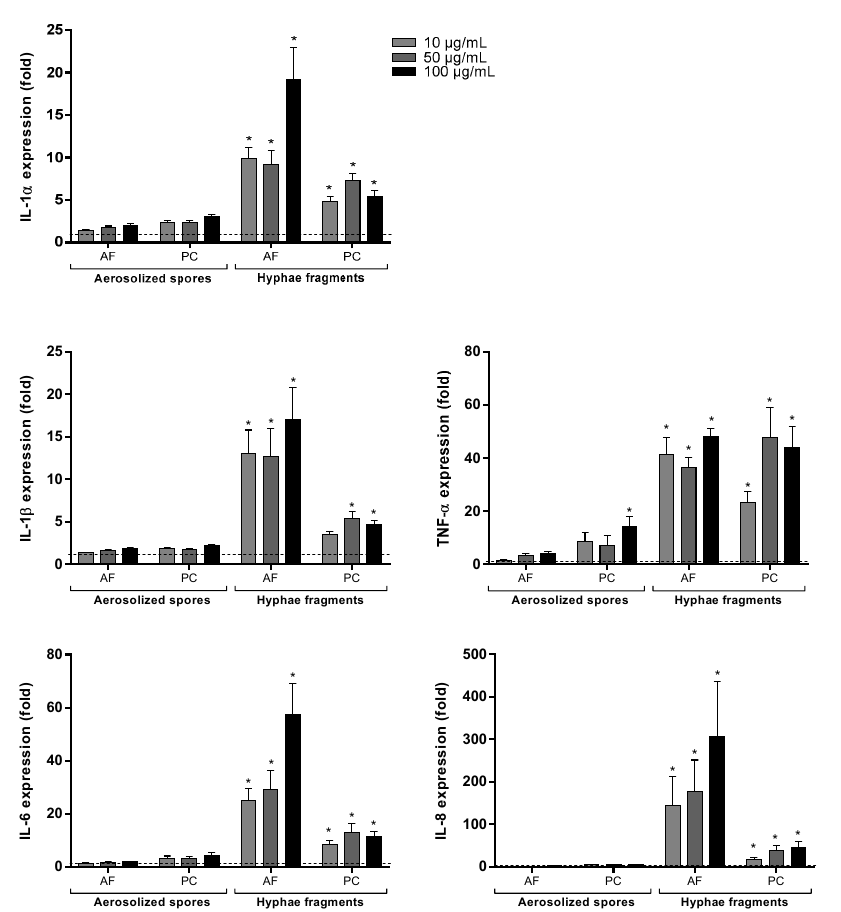
Figure 4. Expression of cytokines/chemokines in BEAS-2B after exposure to spores and hyphal fragments from A. fumigatus and P. chrysogenum . Cells were exposed to three different concentrations (10, 50 and 100 µg dry weight/mL) of X-ray treated aerosolized spores and hyphal fragments for 6 h. Medium blanks were included as control. Expression of IL- α , IL-1 β , TNF- α , IL-6 and IL-8 were measured with real-time RT-PCR. Bars represent mean ± SEM of 4–5 independent experiments. Statistical analyses were performed by two-way ANOVA with Dunnett’s post-tests on log transformed data. Significant difference compared to the control denoted by * p < 0.05.